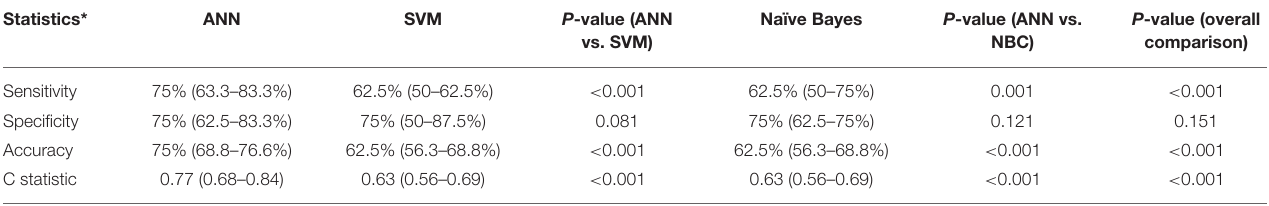
TABLE 2 | Predictive perfrmance of ANN, SVM and NBC